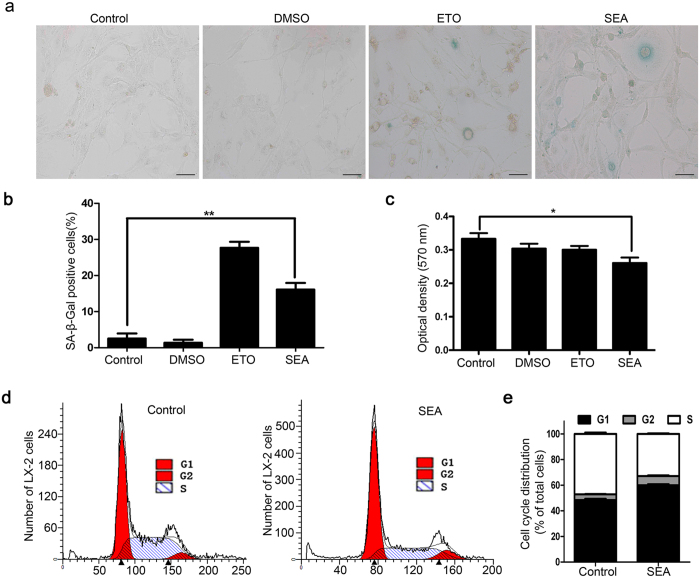
SEA inhibits fibrosis by promoting HSCs senescence.(a) SEA-induced senescence as indicated by SA-β-Gal activities. Dimethyl Sulphoxide (DMSO) and Etoposide (ETO) served as the negative and positive control for senescence, respectively. (b) Statistical analysis for the percentage of SA-β-Gal positive cells among LX-2 cells treated with or without SEA (10 μg/ml). (c) SEA inhibited LX-2 cell proliferation as determined by MTT. (d,e) Cell cycle distribution was measured by flow cytometry analysis at 2 days following SEA treatment. Statistical differences between groups are shown as follows: *p < 0.05; **p < 0.01.